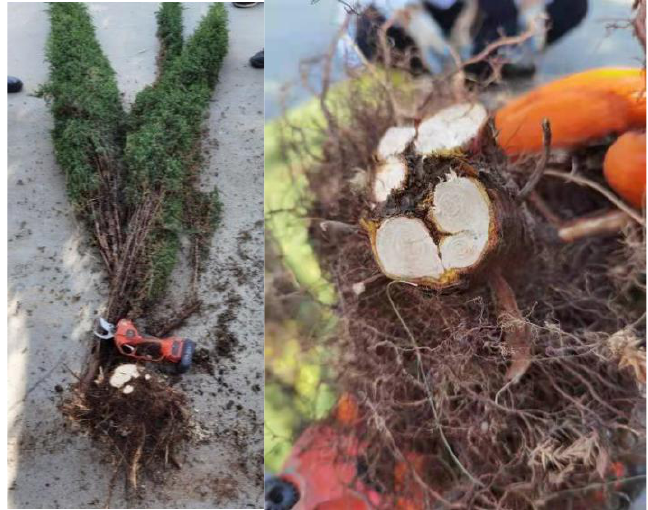
Figure 3. Young Sabina przewalskii samples.